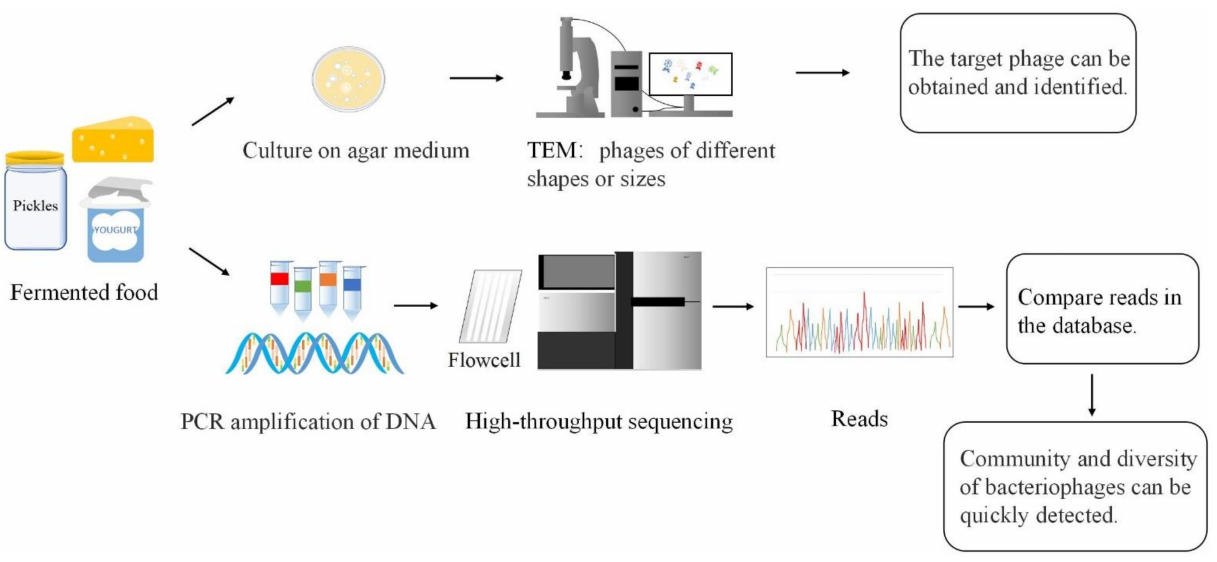
Figure 1. Phage detection flow chart. It shows that culture-based and culture-free methods to detect the presence and diversity of phages in fermented